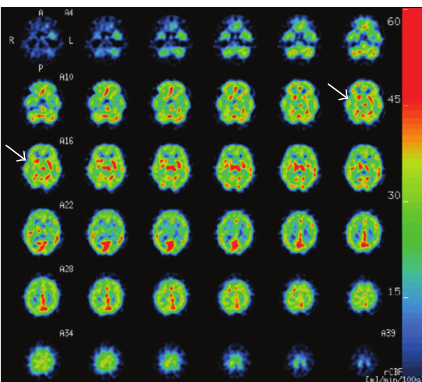
Figure 2: Brain perfusion scintigraphy ( 123 I-IMP) showed a decrease in blood flow in the right lentiform nucleus (arrows) and bilateral symmetrical decreases in blood flow in the frontal, parietal, and temporal lobes.